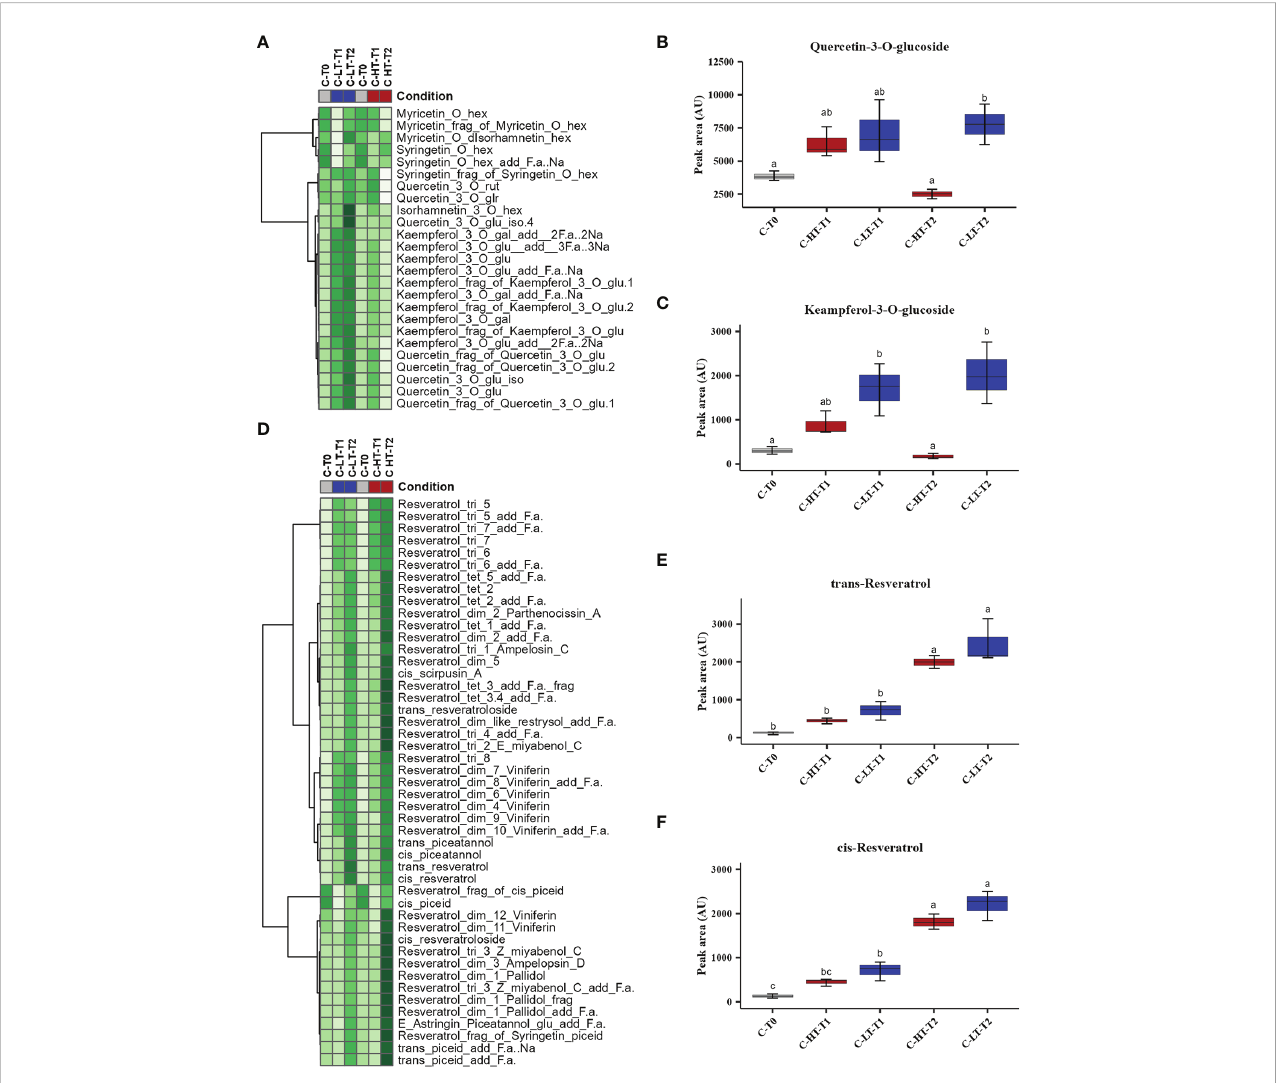
FIGURE 5 Variation of stilbenes and fl avonols in grapes dehydrated in the C-HT and C-LT rooms. (A) Heatmap and Hierarchical Cluster Analyses performed on fl avonols scaled peak areas (AU) measured at harvest (T0) and during withering (T1 and T2) under C-HT and C-LT conditions. Green and white colors represent high and low peak area values, respectively. Pearson correlation coef fi cient was employed to group the different metabolites, using average as clustering algorithm. Abbreviations: add=adduct; frag=fragment; f.a.=formic acid; gal=galactoside; glr=glucuronide; glu=glucose; hex=hexoside; iso=isotope; rut=rutinoside. (B) Quercetin-3-O-glucoside and (C) kaempferol-3-O-glucoside accumulation during withering in high and low temperature conditions. Lowercase letters represent statistically signi fi cant difference based on ANOVA and Tukey post-hoc test with p ≤ 0.05. (D) Heatmap and Hierarchical Cluster Analyses performed on stilbenes. (E) Trans-resveratrol and (F) cis-resveratrol accumulation during withering in high and low temperature conditions. Lowercase letters represent statistically signi fi cant difference based on ANOVA and Tukey post-hoc test with p ≤ 0.05. Abbreviations: add=adduct; dim=dimer; frag=fragment; f.a.=formic acid; gal=galactoside; glr=glucuronide; glu=glucose; hex=hexoside; iso=isotope; rut=rutinoside. tri=trimer; tet=tetramer. Gray colour indicates grapes at harvest (T0); blue colour indicates the C-LT condition; red colour indicates the C-HT